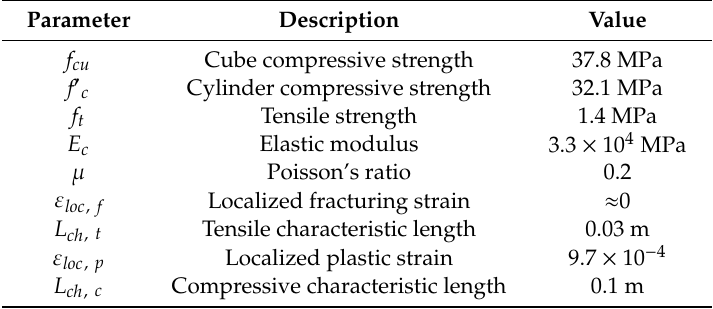
Table 2. Parameters of the concrete material model.